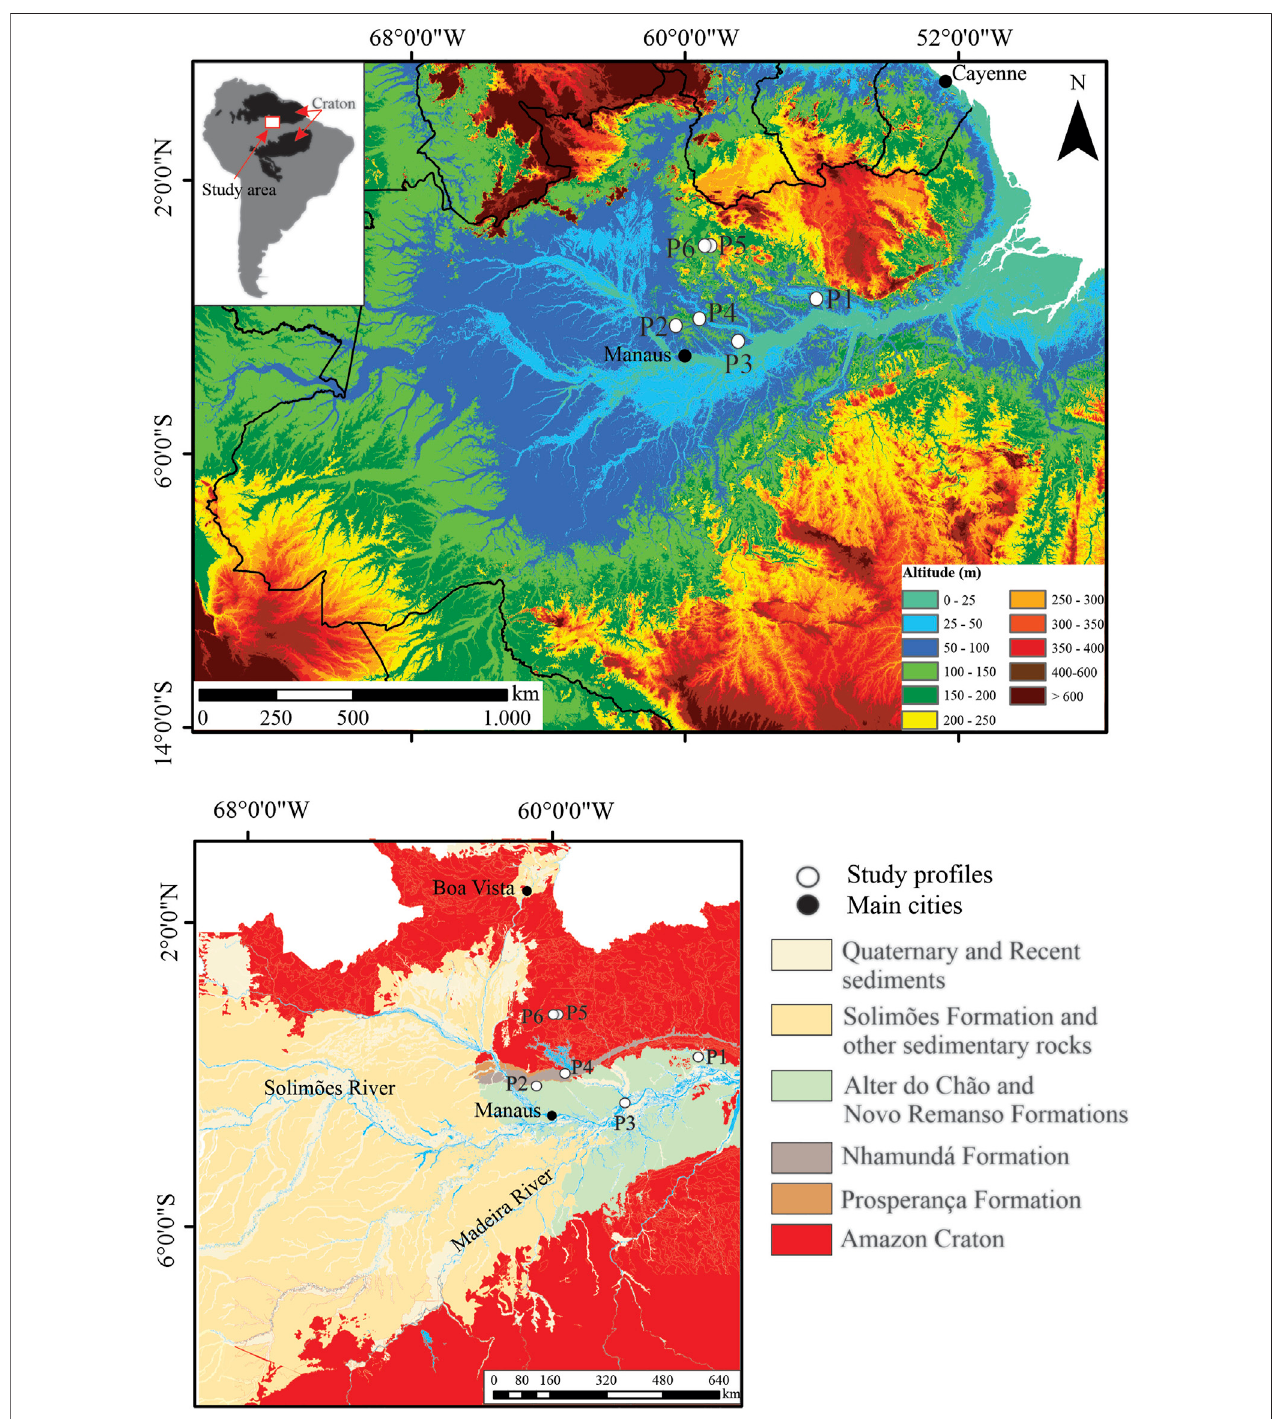
FIGURE 1 | Geographical and geological landscape of the studied region and location of the sampled pro fi les.